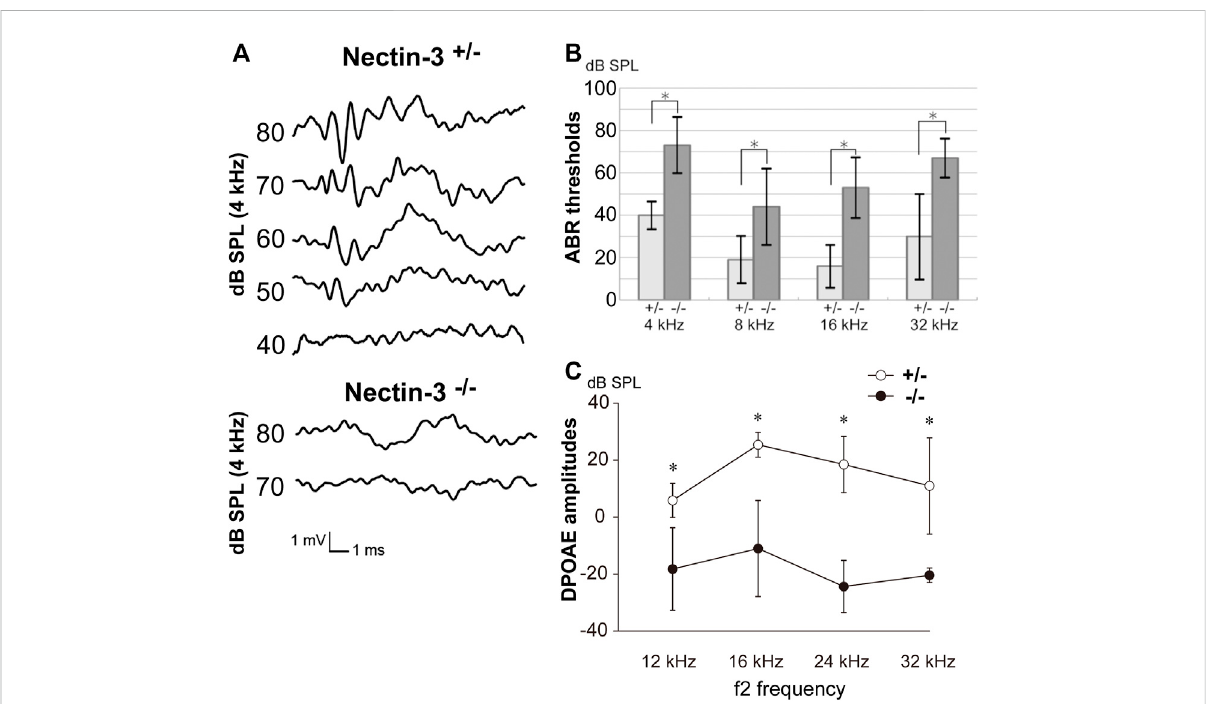
FIGURE 1 Auditory defects of nectin-3 KO mice (A) ABRs to stimuli of 40 – 80 dB SPL at 4 kHz in P28 nectin-3 +/ – and nectin-3 − / − mice. Typical data for a nectin-3 +/ – mouse and a nectin-3 − / − mouse are shown. (B) Hearing thresholds at sound frequencies of 4, 8, 16, and 32 kHz of nectin-3 +/ – ( n = 3) and nectin-3 − / − mice (n = 3) on P28. Nectin-3 − / − mice showed increased thresholds (55 – 75 dB sound pressure level (SPL)) compared with nectin-3 +/ – mice(15 – 40 dBSPL).Allaveragedataonthegraphsareshownasmean±SD.Inallinstances, p valueswerelessthan0.05andconsideredtobe signi fi cant. *, p < 0.05. (C) DPOAEs of P28 nectin-3 +/ – (white dots), and P28 nectin-3 − / − (black dots) mice represented as a function of f2 stimulus frequencies,rangingfrom12 kHzto32 kHz.Nectin-3 − / − miceshowedattenuatedresponsesatthisstage(mean±SD; n =8fornectin-3 +/ – mice, n = 13 for nectin-3 − / − mice). *, p <